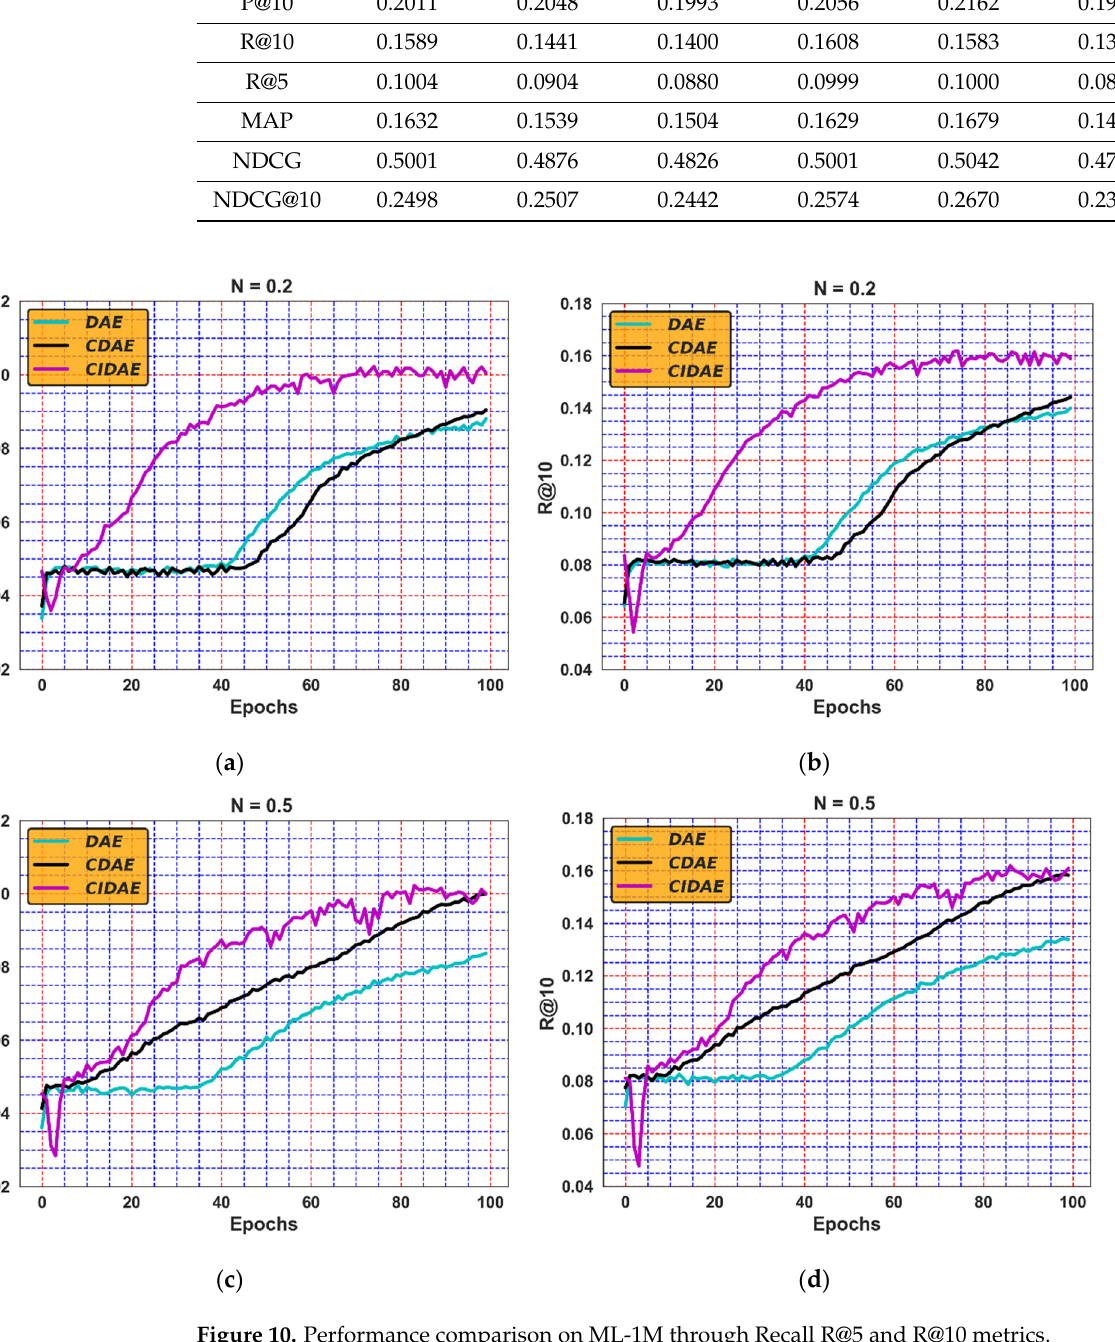
Figure 10. Performance comparison on ML ‐ 1M through Recall R@5 and R@10 metrics.